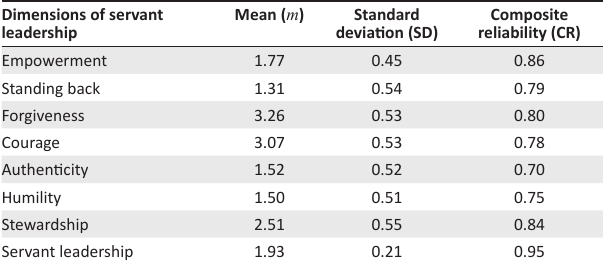
TABLE 2: Reliability scores per